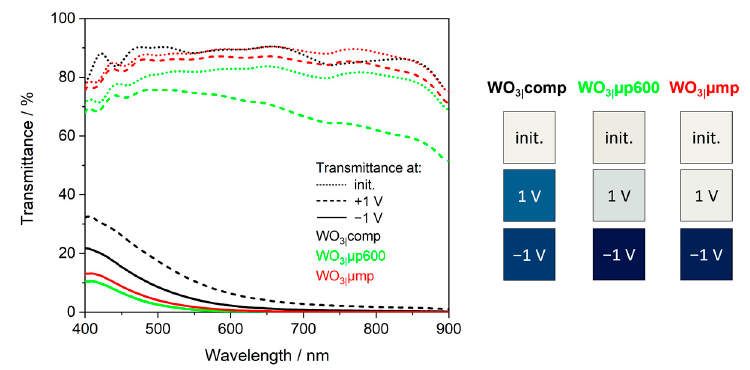
Figure 8. Transmittance spectra of 646 nm thick WO 3| comp (black), 702 nm thick WO 3| µ p600 (green) and 620 nm thick WO 3| µ mp (red) films measured in contact to LiClO 4 in PC at a scan rate of 5 Mv s − 1 in the initial states (init.), the bleached (1 V) and the colored ( − 1 V) states at the second cycle. The corresponding calculated color impressions are shown to the right.